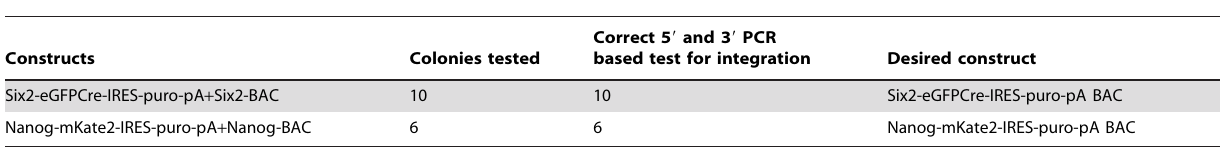
Table 3. Efficiency of the recombineering reactions used.